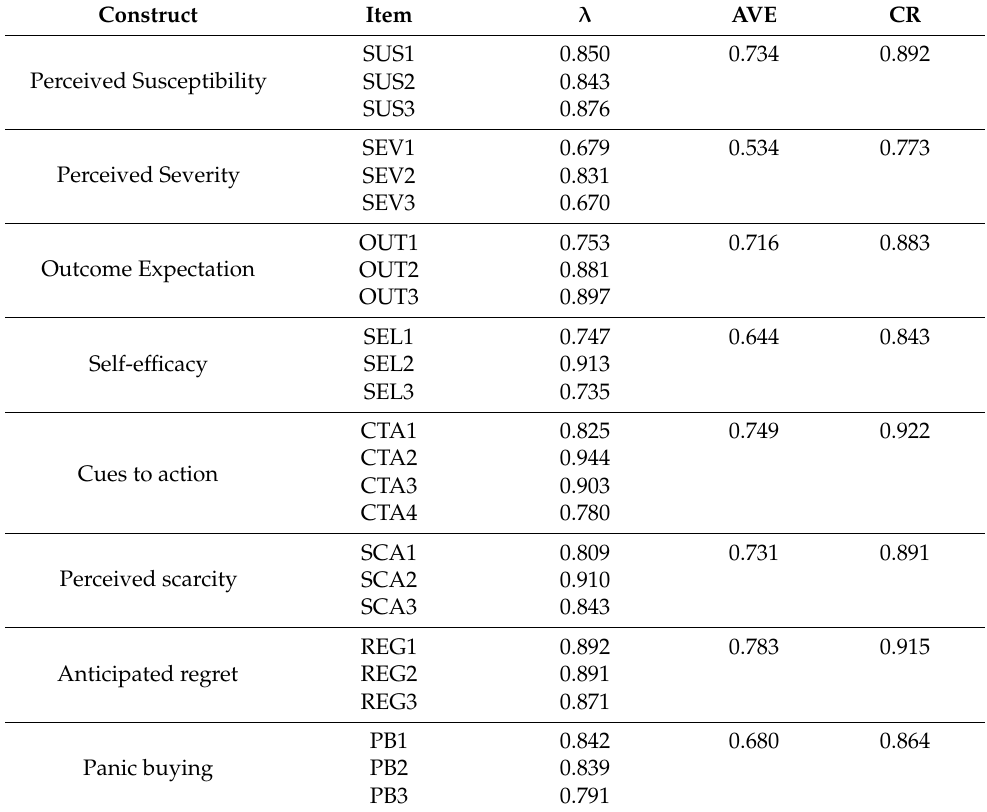
Table 4. Confirmatory factor analysis